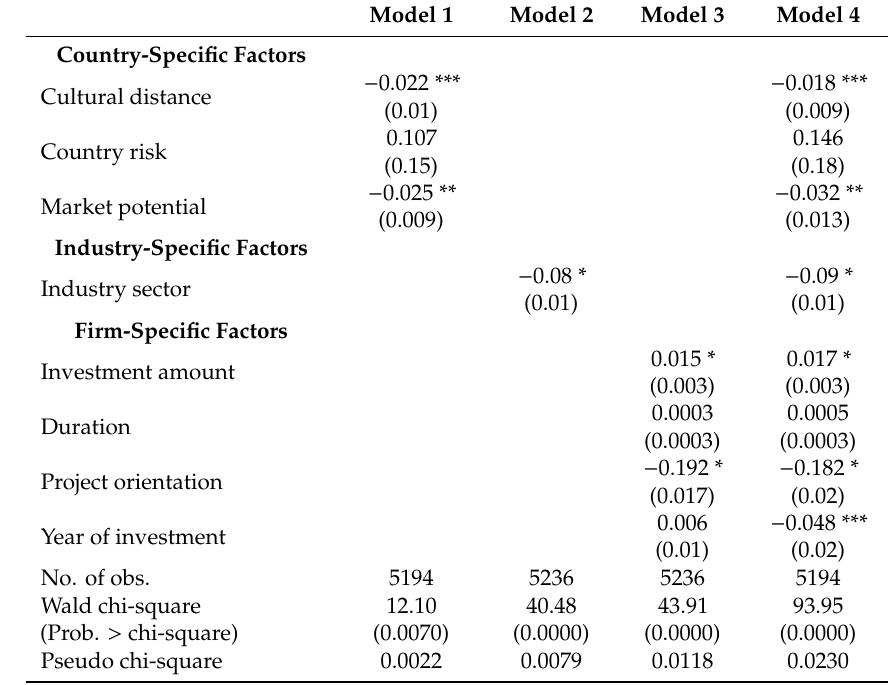
Table 2. The E ff ect of Cultural Distance on the Entry Mode Choice of Foreign-Invested Firms in Vietnam (Marginal E ff ect of the Logit